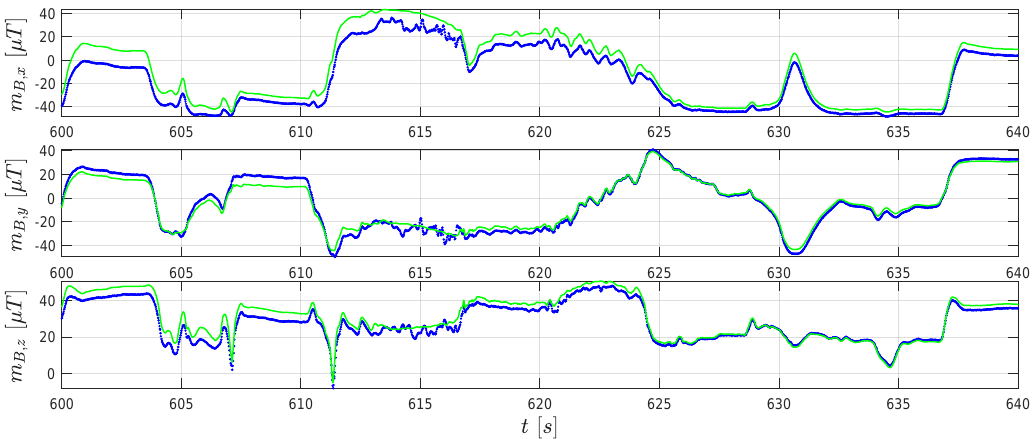
Figure 12. Real magnetometer measurements m B, mag (blue dots) and the extended RTS smoother estimated magnetometer measurements m B, meas (green line).